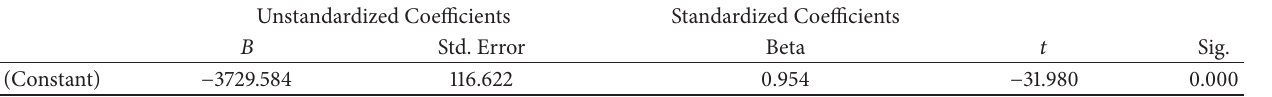
Table 2: Coefficients in Figure 2.